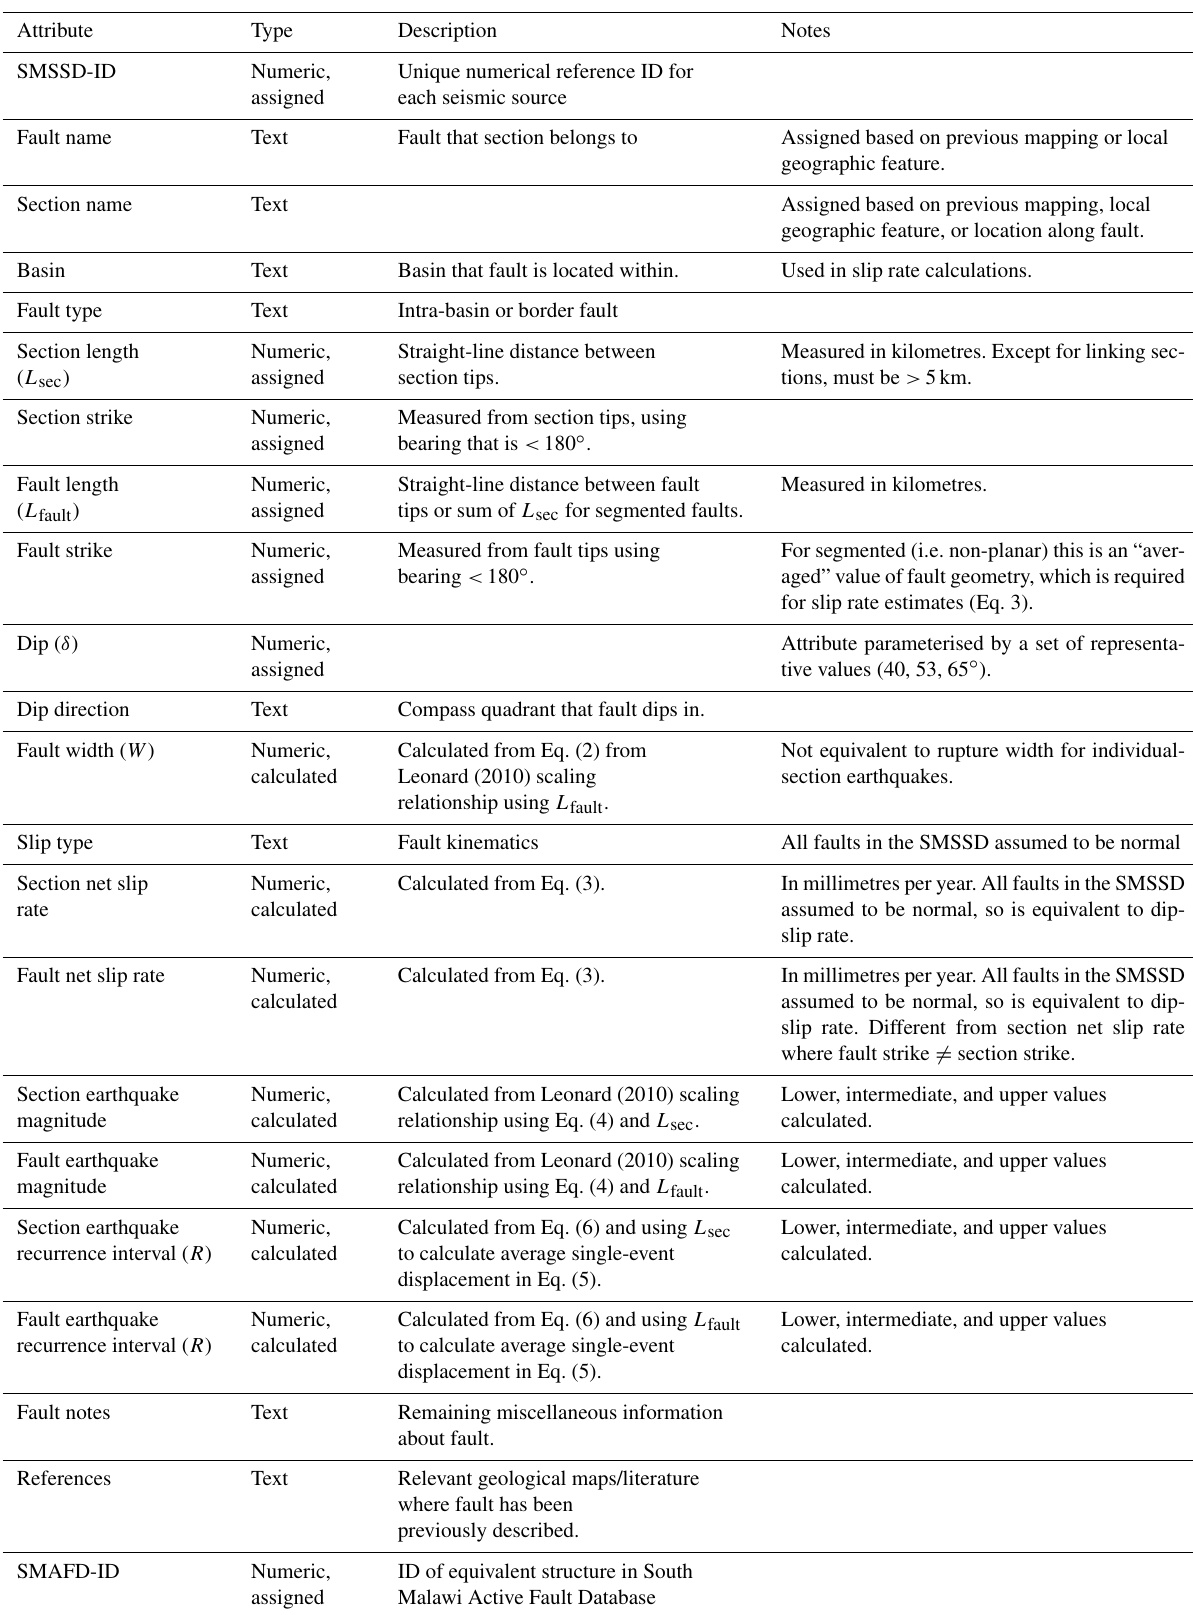
Table 2. List and brief description of fault geometry, slip rate estimates, and earthquake source attributes in the